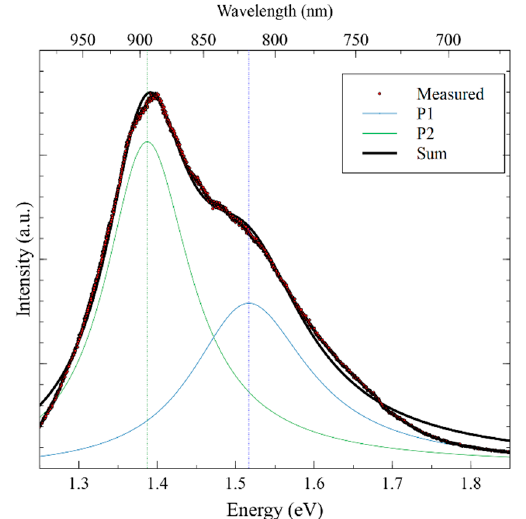
Figure 5. Photoluminescence and fitted peaks for CZTS thin film taken at room temperature.